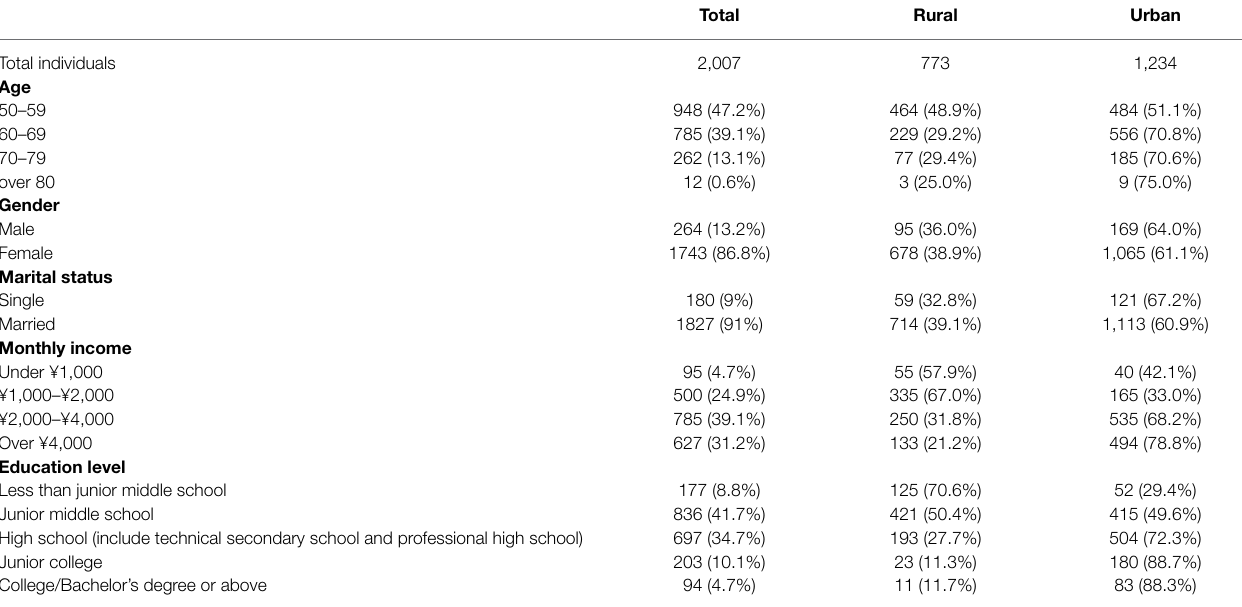
TABLE 1 | Participants’ demographic